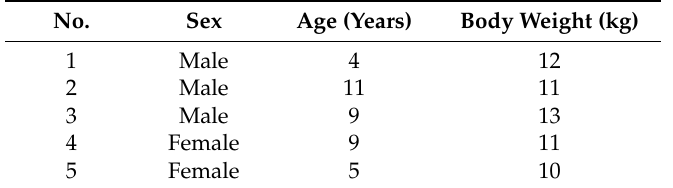
Table 1. Characteristics of dogs included in this study.